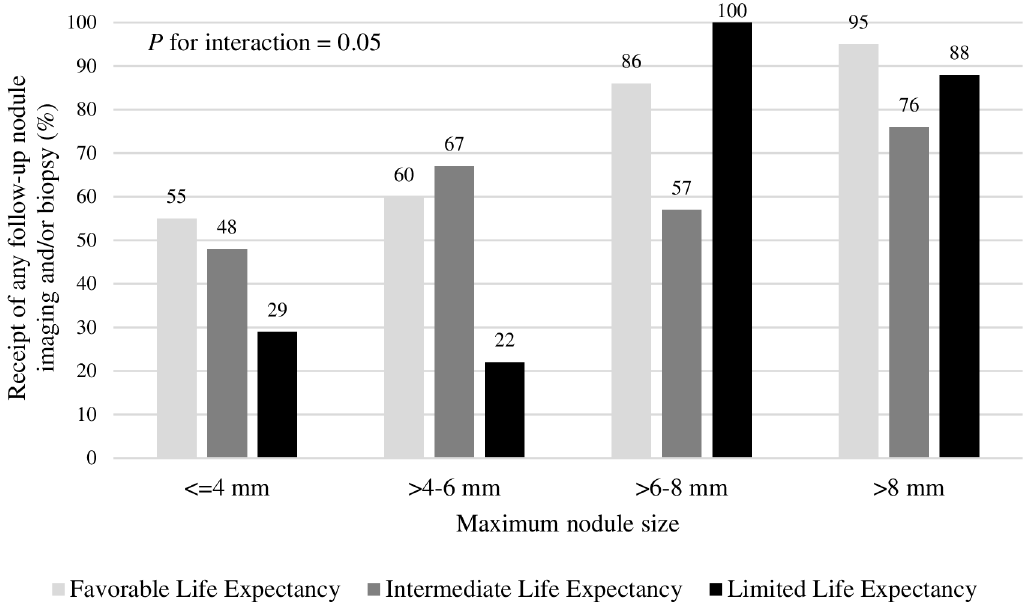
Fig 3. Receipt of any follow-up nodule imaging and/or biopsy during four-year follow-up in older veterans with newly diagnosed pulmonary nodules by life expectancy and nodule size. Patients were categorized as having limited life expectancy if age was (cid:21) 85 with CCI (cid:21) 1 or if age was (cid:21) 65 with CCI (cid:21) 4. Patients were categorized as having favorable life expectancy if age was 65–74 with CCI 0. The remaining patients were categorized as having intermediate life